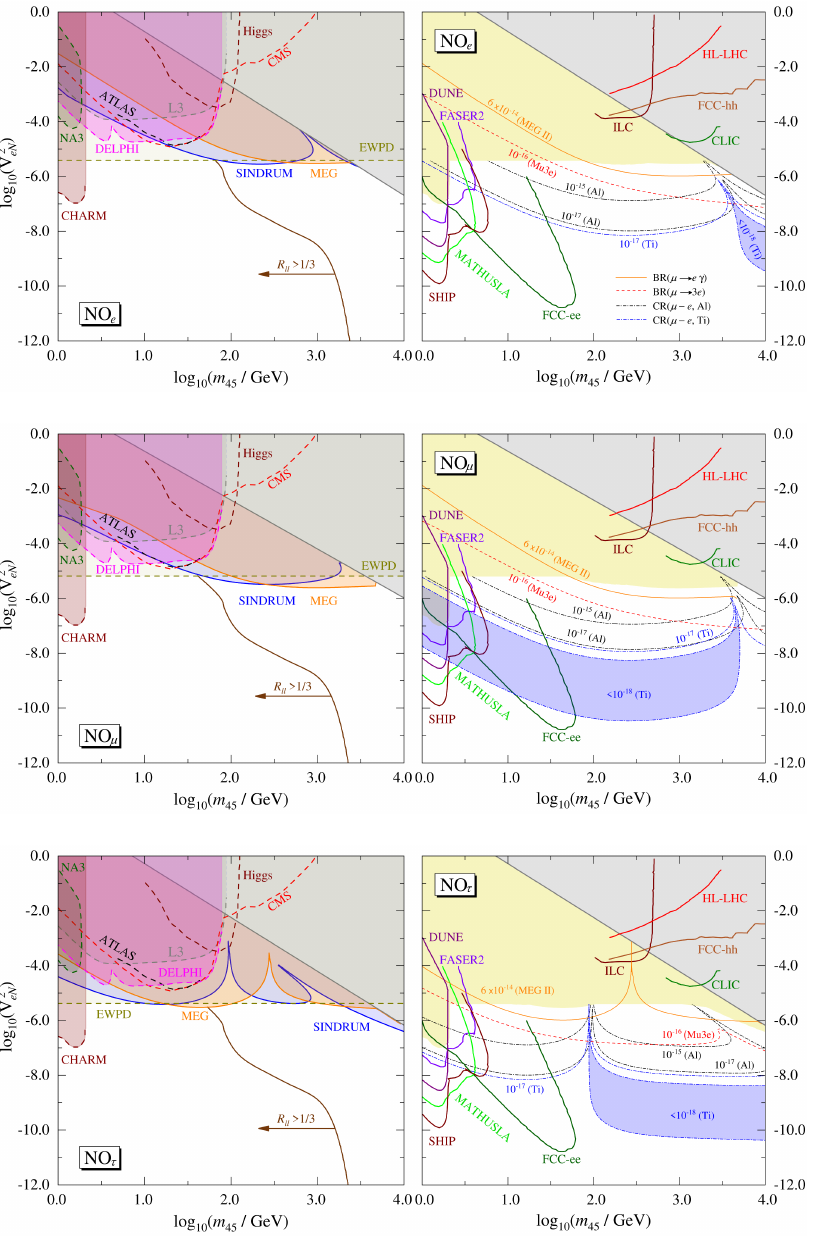
) parameter space by the MEG and SIN- eN > 5 within the i 1 / 3 . (Right) Projected sensitivities ll > (NO ) e µ